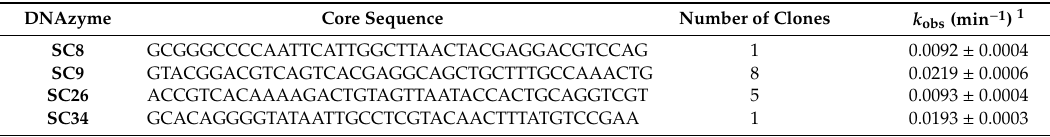
Table 1. Overview of deoxyribozyme core sequences and observed rate